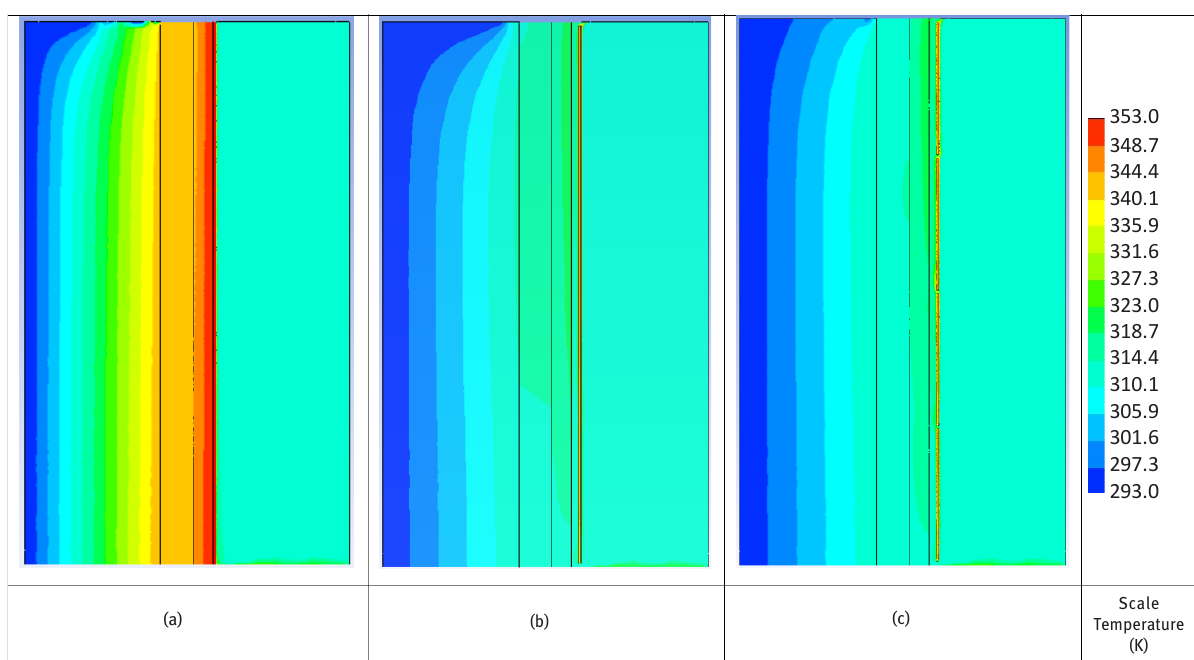
Fig. 6. Temperature distribution maps of the facade obtained during numerical Figure 6: Temperature distribution maps of the facade obtained during numerical simulation: (a) standard facade, (b) closed-joint ventilated facade and (c) open-joint ventilated simulation: (a) standard facade, (b) closed - joint ventilated facade and (c) open - joint ventilated facade.